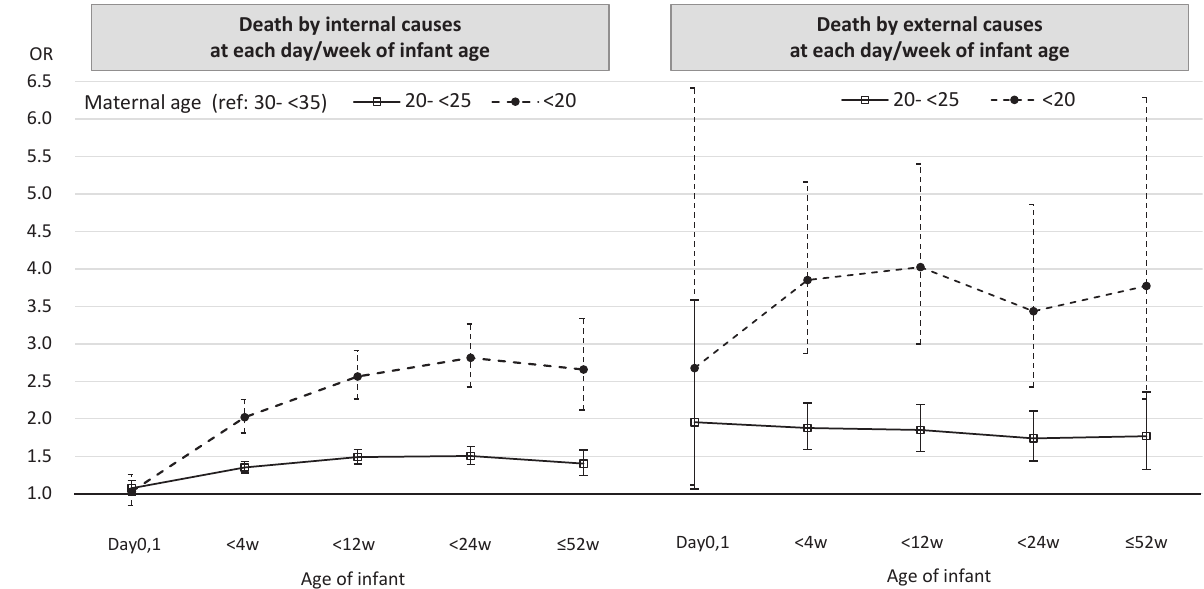
Figure 2. Young maternal age and infant death at each day / week of infant age compared to mothers aged 30 – 34 years